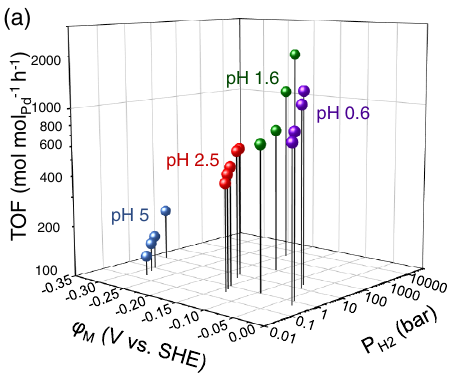
Fig. 7 | Comparison of the reaction rates at OCV and external electric poten- tials. a TOF as a function of electric potential of Pd ( φ M ) and P H 0.6 (0.5 – 20bar), pH 2.5 (0.3 – 10bar) and pH 5 (0.2 – 10bar) and external electric